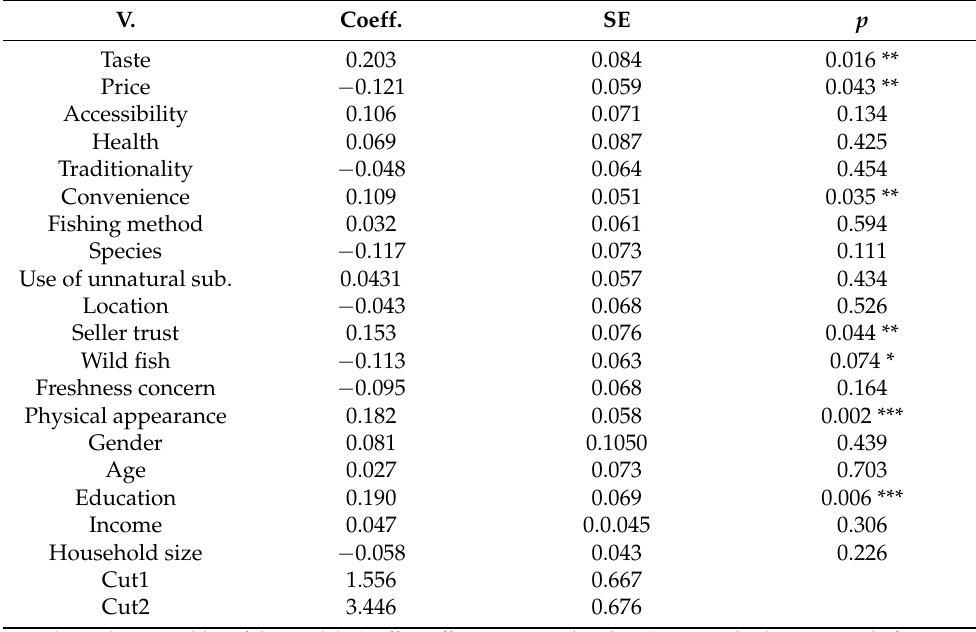
Table 5. Ordered probit model coefficient